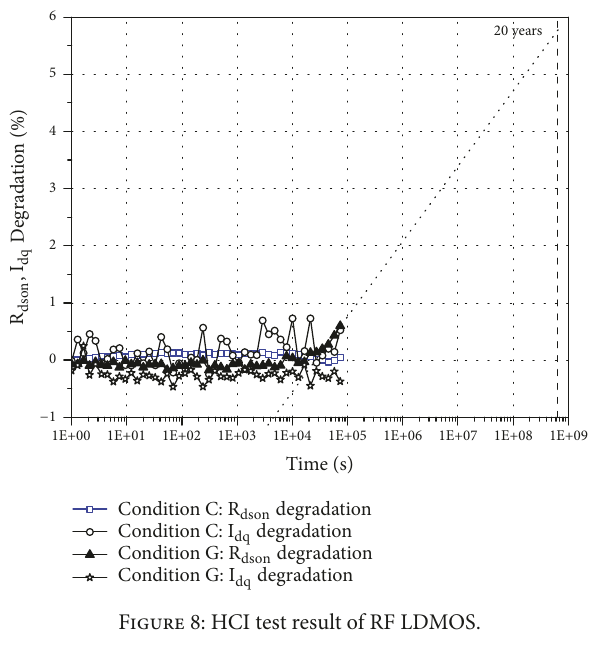
Figure 10: ACPR of conditions A, C, and G.